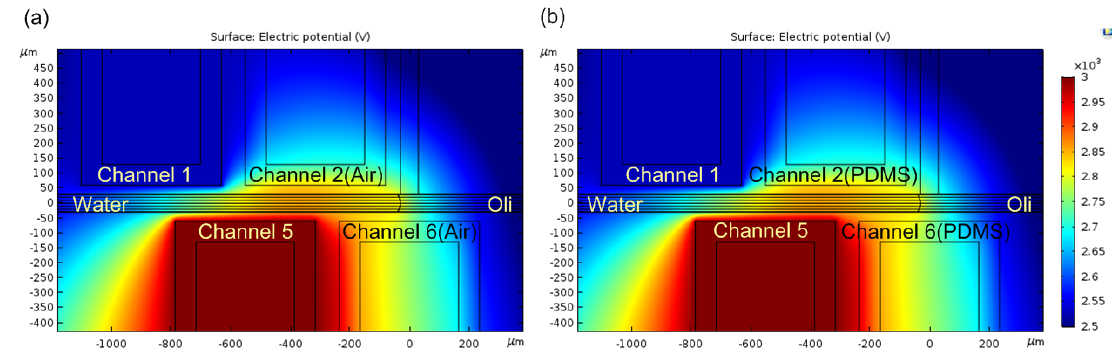
Figure 4. Electric potential distribution of scheme 1 and scheme 2. ( a ) Electric potential distribution of scheme 1; ( b ) electric potential distribution of scheme 2. The difference was the filling material of non-electrode Channel 2/6, with air in scheme 1 and PDMS in scheme 2. Three thousand volts was applied on Channel 5.